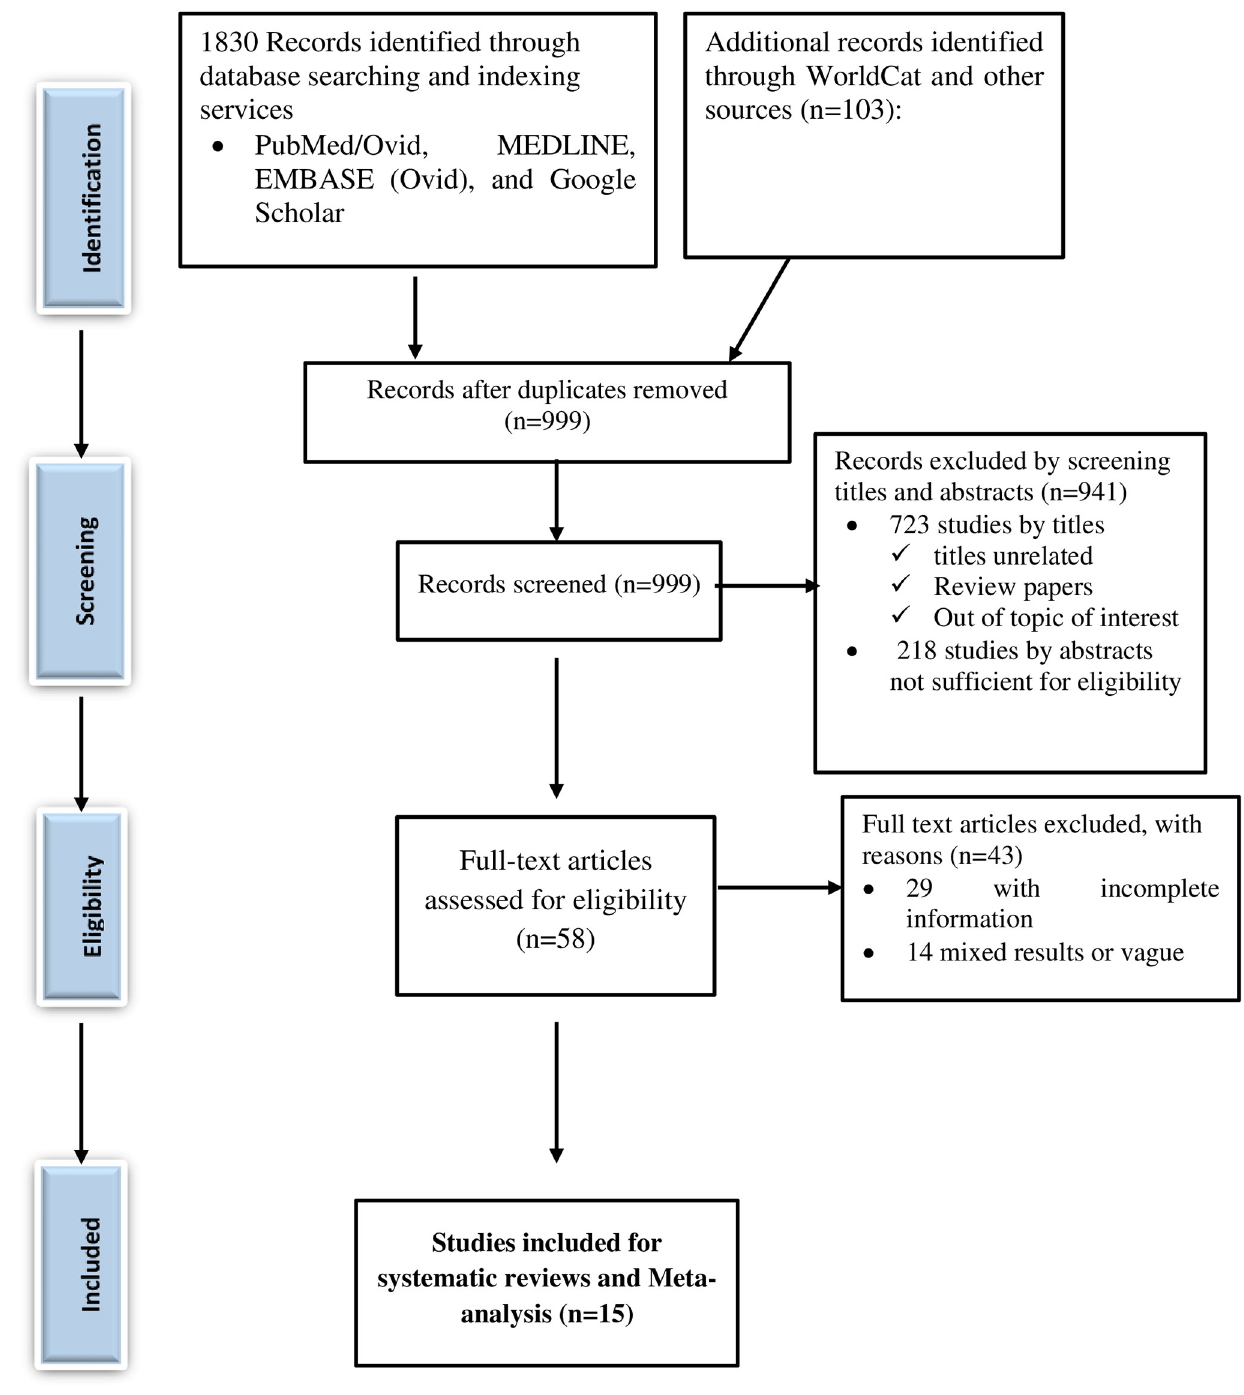
Fig 1. PRISMA flow diagram depicting the selection process of identified studies.